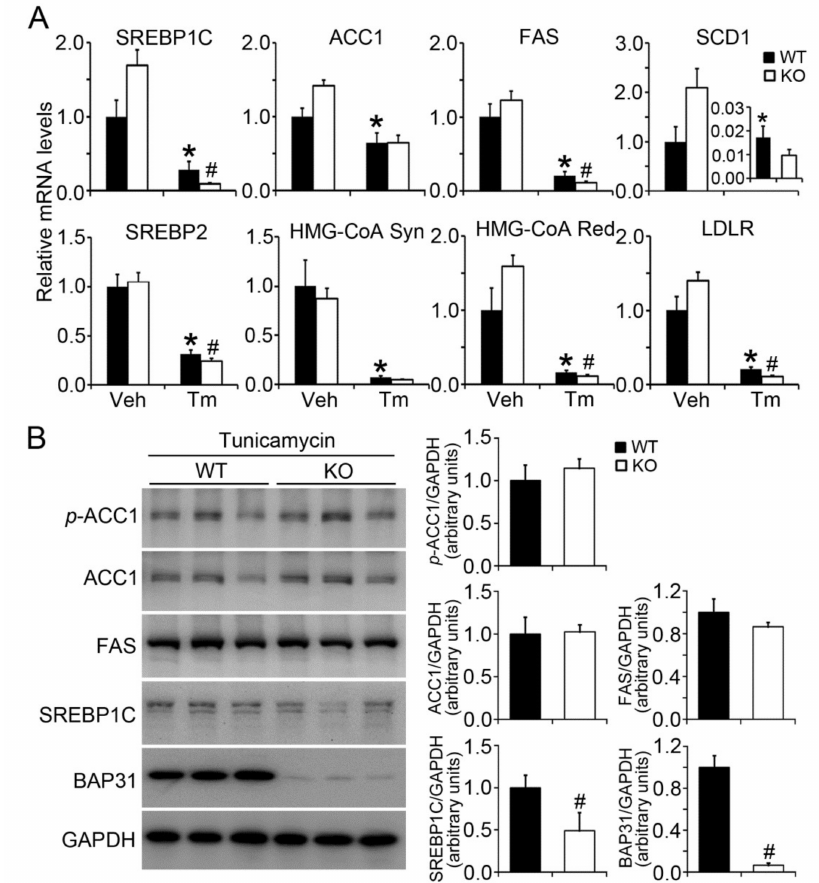
Figure 3. BAP31 deficiency reduced lipogenic gene expression in Tunicamycin-injected mice. ( A ) Total RNA was extracted from the liver tissues. The relative mRNA levels were determined by quantitative real-time PCR and normalized with 18S rRNA levels. n = 7–8 per group. ( B ) Immunoblot analysis of BAP31, SREBP1C, FAS, ACC-1, p -ACC1 in livers from mice injected with Tunicamycin for 48 h. Data represent as mean ± SEM. *, p < 0.05, Tm compared with Veh group. #, p < 0.05, KO compared with WT mice injected with